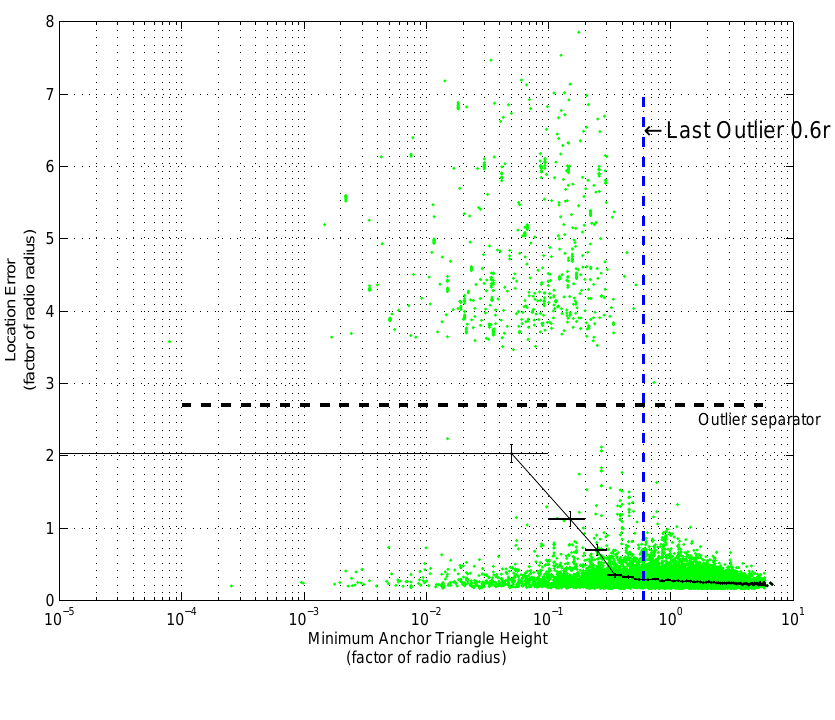
Figure 5. Histogram: Minimum anchor height vs . localization error, grouped in intervals of